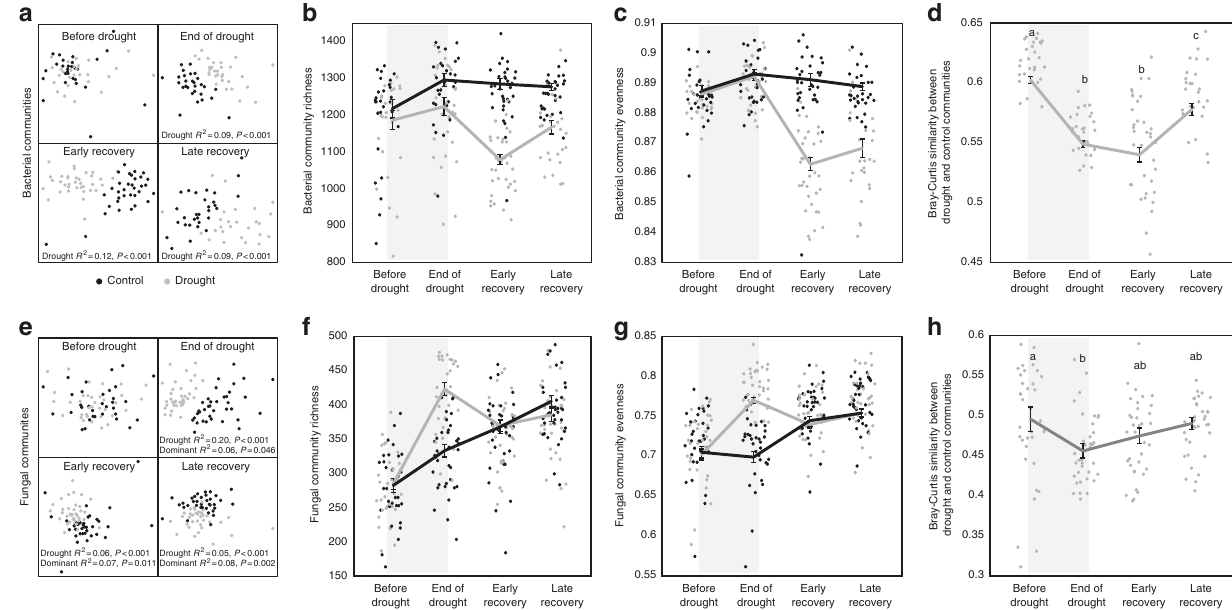
Fig. 1 Bacterial and fungal community response to drought. The duration of the drought is indicated as a shaded area in b – d and f – h . NMDS of bacterial ( a ) and fungal ( e ) community composition shows that drought signi fi cantly affected bacterial and fungal communities at all sampling dates following drought (ADONIS). Bacterial ( b , c ) and fungal ( f , g ) richness and evenness were strongly affected by drought, but this response differed over time (Repeated measures ANOVA sampling × Drought interaction F 3,153 = 10.4, P < 0.001 and F 3,195 = 14.8, P < 0.001 for richness of bacteria and fungi, respectively; Sampling × Drought interaction F 3,153 = 23.1, P < 0.001 and F 3,195 = 23.1, P < 0.001 for evenness of bacteria and fungi, respectively). The similarity between drought and control communities changed over time for both bacteria and fungi, but bacterial drought and control communities were still less similar than before drought at late recovery (ANOVA sampling effect F 3,80 = 40.9, P < 0.001 and F 3,103 = 2.8, P = 0.04 for bacteria and fungi, respectively). In b – d and f – h , dots represent individual observations and lines indicate means ± 1 SE. In d , h , symbols with the same letter are not